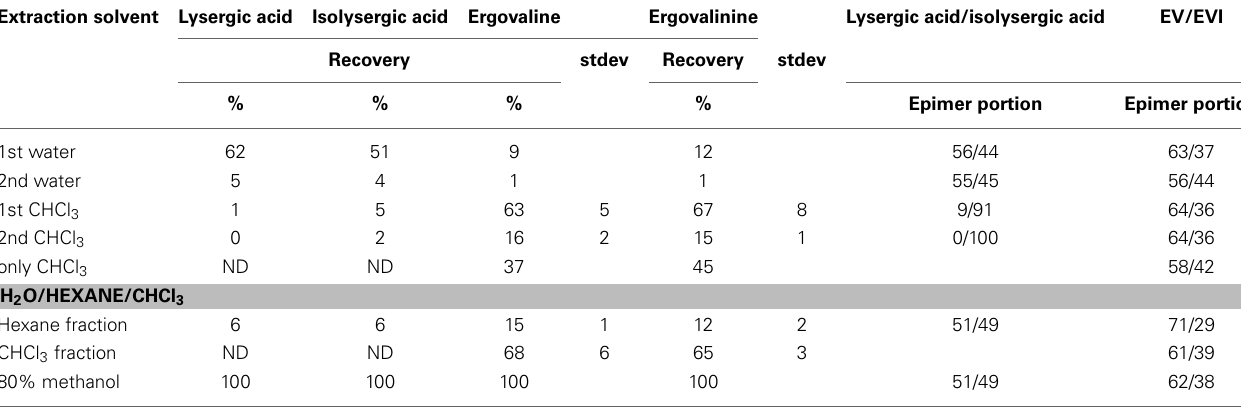
Table 3 | Purification attempts from initial seed extract. Extraction solvent Lysergic acid Isolysergic acid Ergovaline